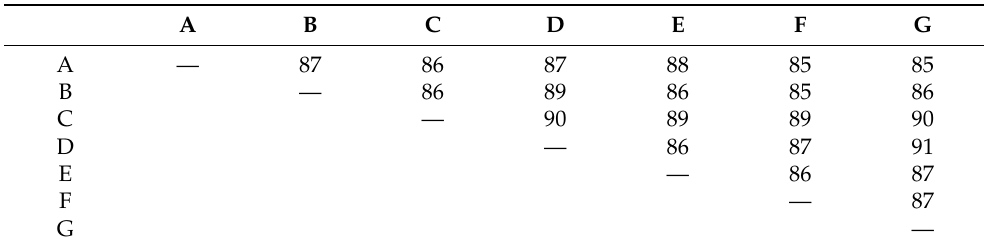
Table 1. The pairwise agreement (expressed as a percent) between the seven interpreters (A to G) based on all land cover classes for the 2010 data.